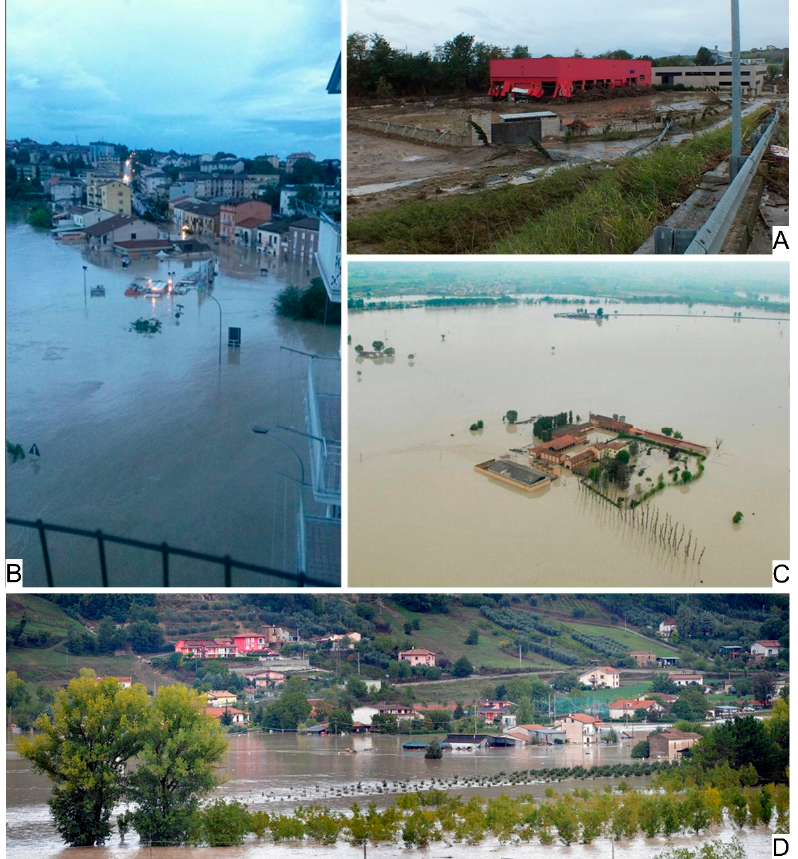
Figure 9. Overflow of the Calore river: ( A ) Damages in the industrial area of Benevento; ( B ) flooding at the “Ponticelli” locality, Benevento town; ( C ) and ( D ) flooding at the “Pantano” locality, Benevento town.